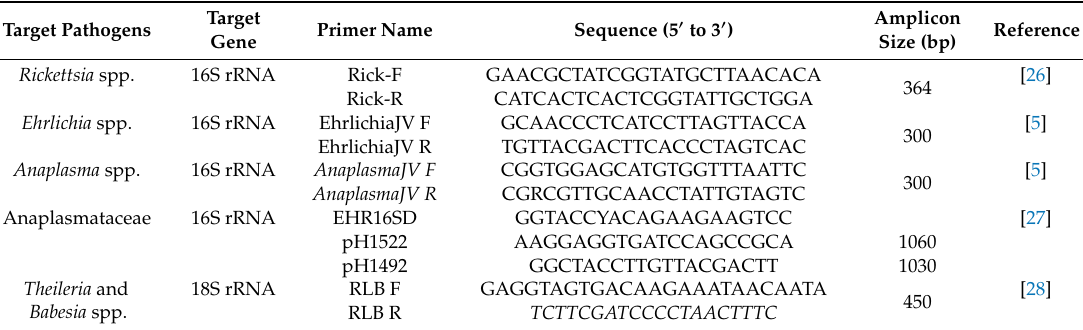
Table 1. Primers used in identification of